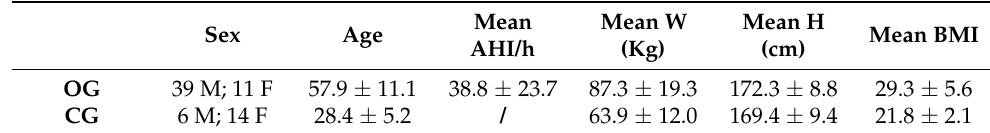
Table 1. Characteristics of OSAS group and control group.